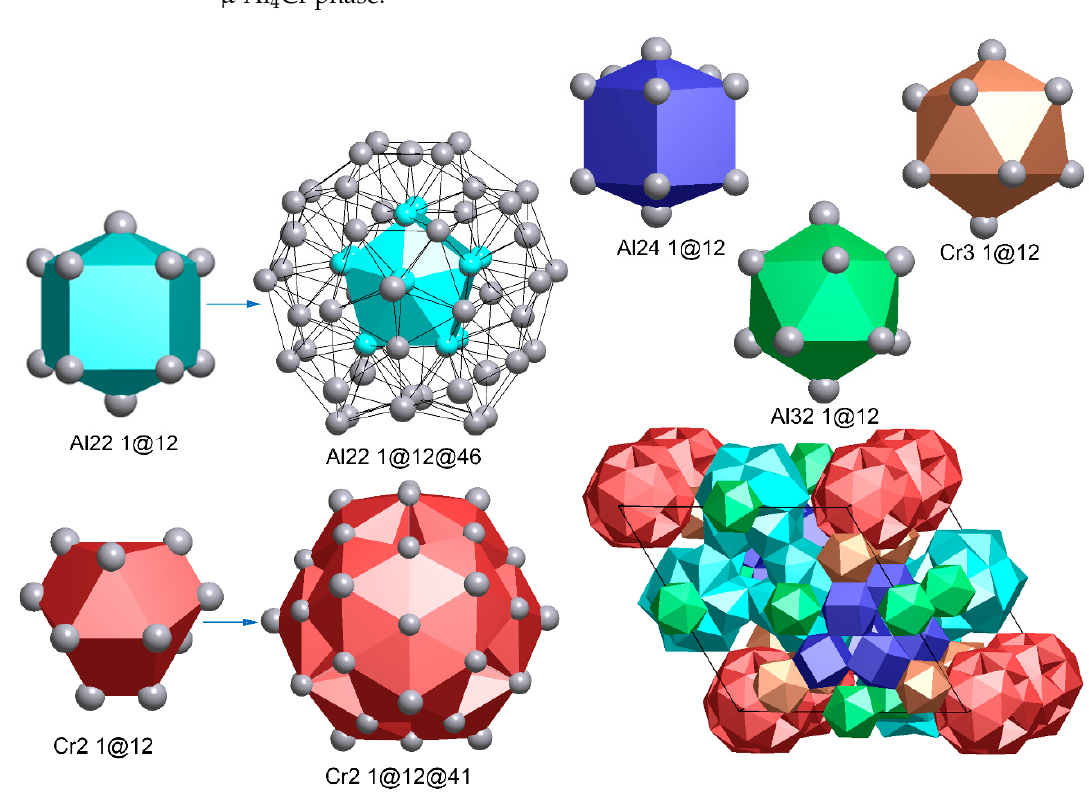
Figure 3. The entire unit cell of µ -Al 4 Cr structure composed of six cluster units.